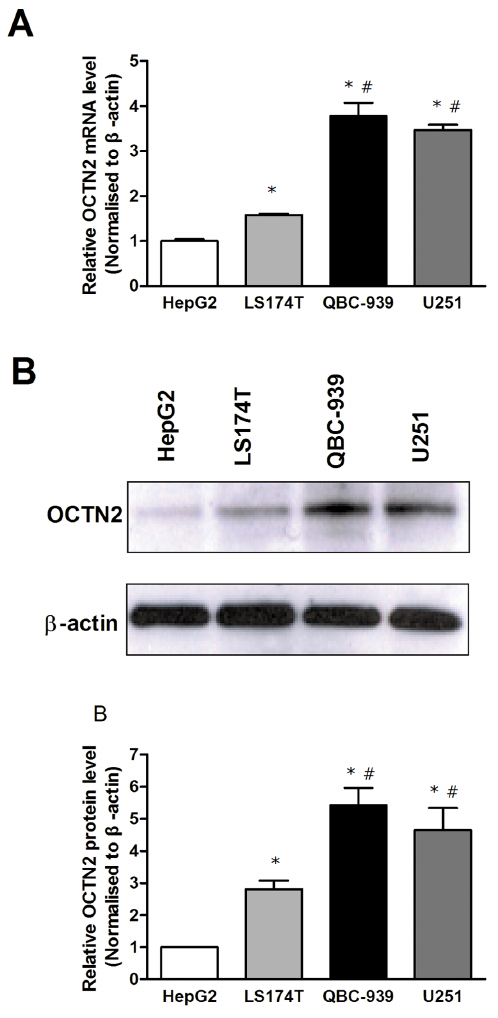
Figure 1. Expression of OCTN2 in cancer cell lines. (A), analysis of mRNA levels of OCTN2 in cancer cell lines. Total RNA in cancer cells was purified by TRIzol reagent for cDNA synthesis and the mRNA levels of OCTN2 were analyzed by Quantitative RT-PCR. (B), analysis of protein levels of OCTN2 in cancer cells. Total proteins were extracted and protein levels of OCTN2 were analyzed by western blotting. The relative expression of mRNA and protein was normalized to b -actin. The expression of HepG2 was set as 1. All of mRNA and protein analysis were performed three times. Significant difference from HepG2 or LS174T cell is denoted with asterisk (*, p , 0.05) or number sign ( # , p , 0.05), respectively.